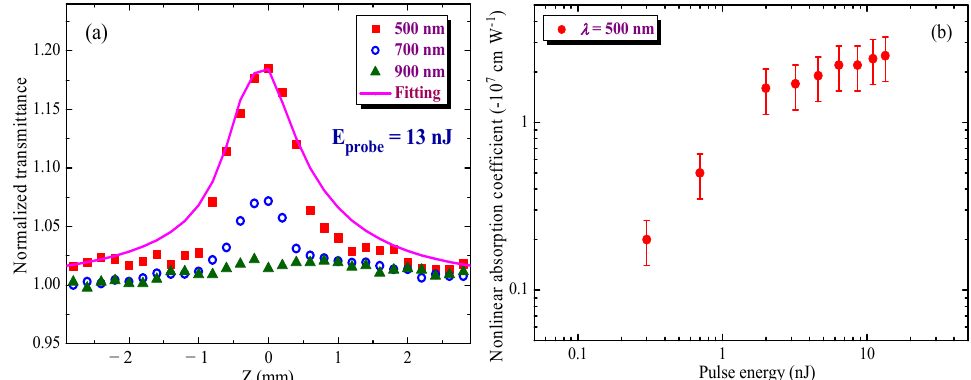
(Figure 6b, red empty circles).